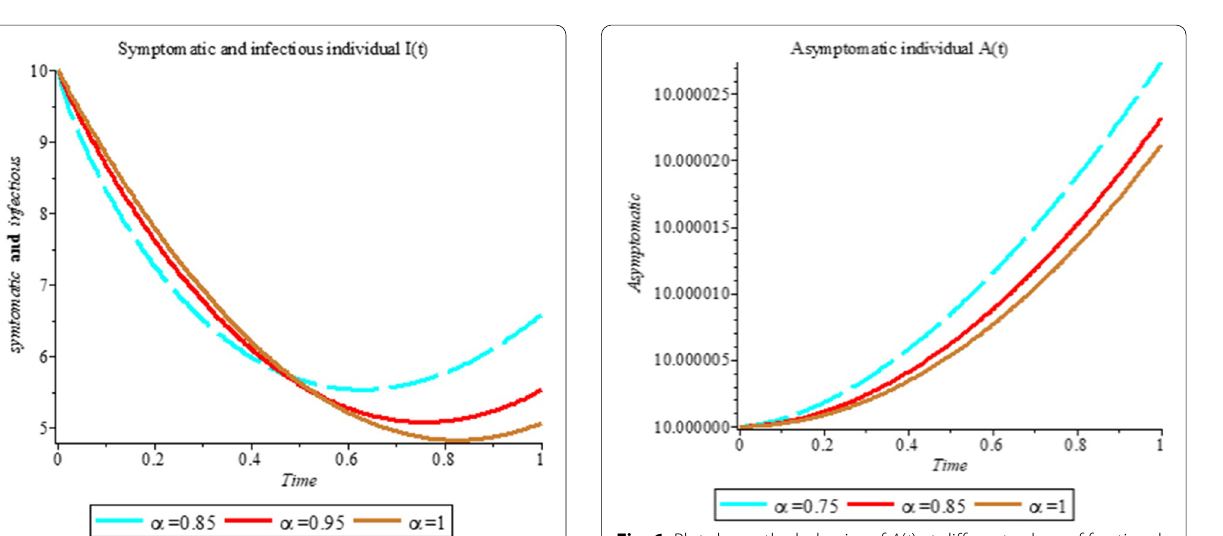
Fig. 6 Plot shows the behavior of A ( t ) at different values of fractional order α